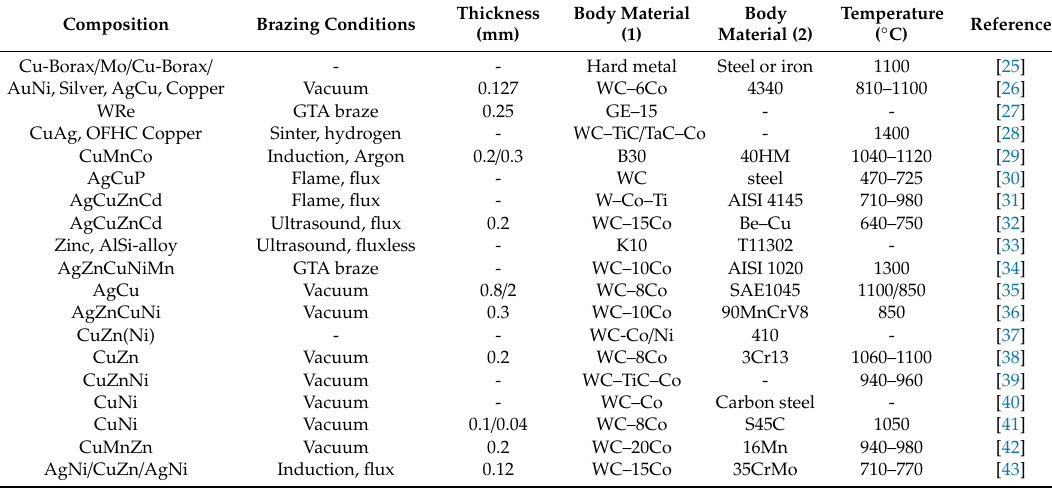
Table 2. Chemical composition of filler metals and their brazing conditions and temperatures. OFHC, oxygen-free high conductivity; GTA, gas tungsten-arc.